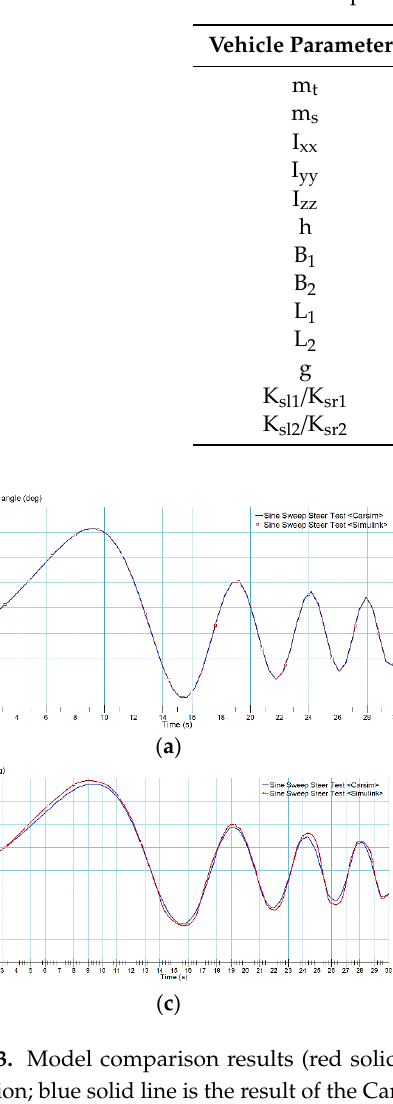
Table 1. Main parameters of vehicle model.